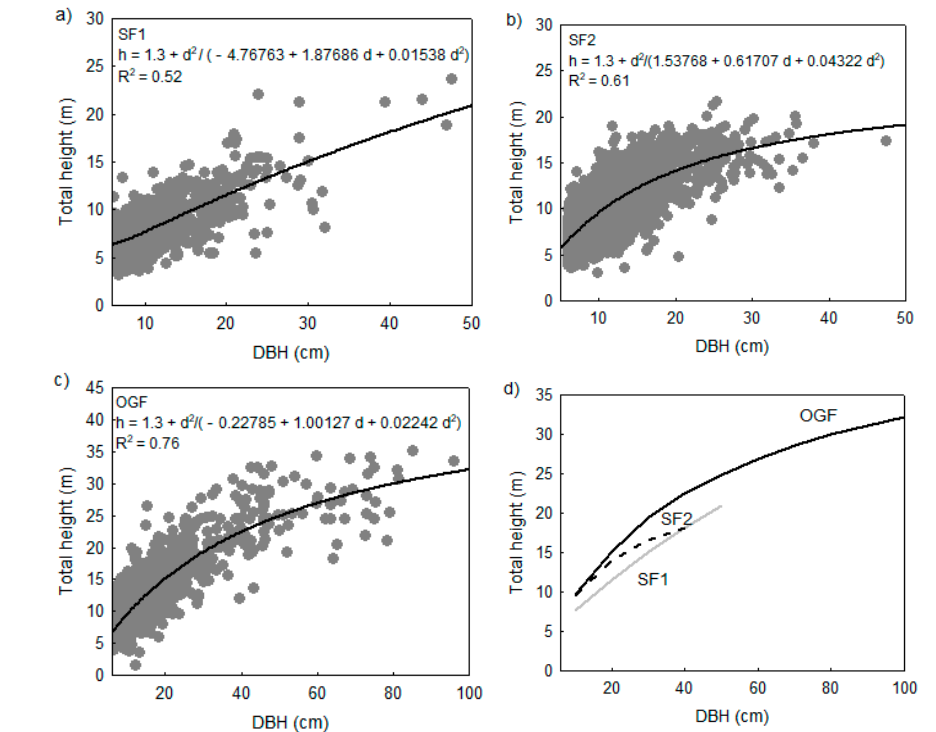
Figure 2. DBH–total height relationship of trees in three forest types.